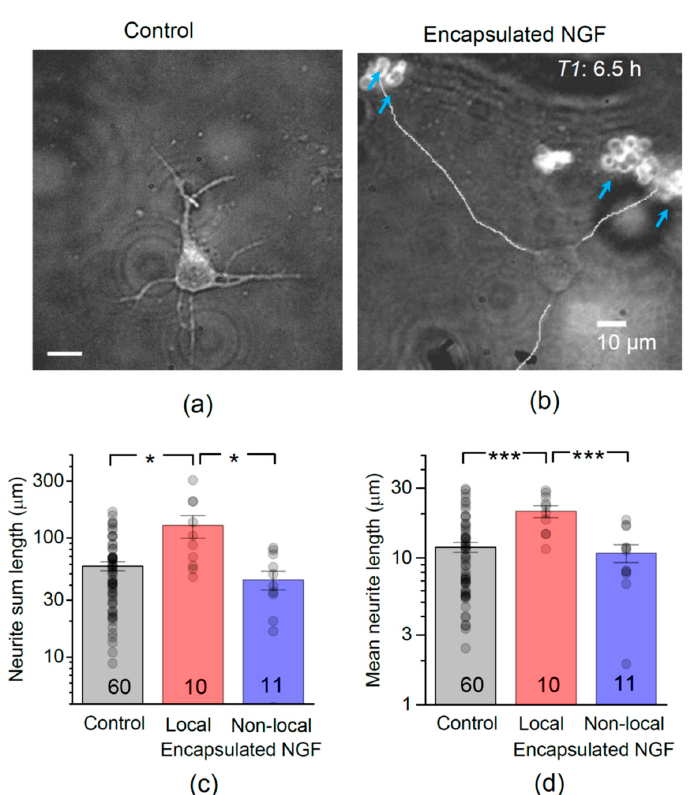
Figure 2. Encapsulated NGF boosts neurite outgrowth in developing hippocampal neurons in vitro. ( a ) A snapshot of developing hippocampal neurons, at 6.5 h after plating, in control conditions. ( b ) As in ( a ) but in the presence of NGF-loaded LbL-microcapsules; blue arrows, clusters of microcapsules labelled by TRITC; merged DIC and TRITC fluorescence channels; line-traced neurites illustrate neurite length measurement in individual cells. ( c ) Statistical summary of total neurite length (sum of individual neurite lengths) per neuron, 6.5 h after plating, in control conditions (no microcapsules), and in the presence of encapsulated NGF for local (<50 µm from capsules) and non-local (>50 µm away) cells, as indicated; numbers of cells shown. Dots, individual cell data; bars, mean ± s.e.m; * p < 0.05 (two-tailed unpaired t -test); ordinate, log scale. ( d ) Statistical summary for the mean neurite length per individual cell; *** p < 0.001 (two-tailed unpaired t-test); other notations as in ( c ). At this development stage, the neurite outgrowth rate was ~1.8 µm h − 1 in control neurons, but ~3.2 µm h − 1 in local neurons, an increase of ~78% (Figure 3a). The neurite outgrowth rate remained unchanged (~1.7 µm h − 1 ) in non-local neurons (Figure 3a).